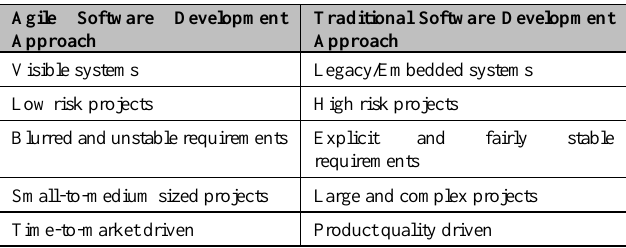
TABLE I S OFTWARE P ROJECTS AND THE B ASIC S